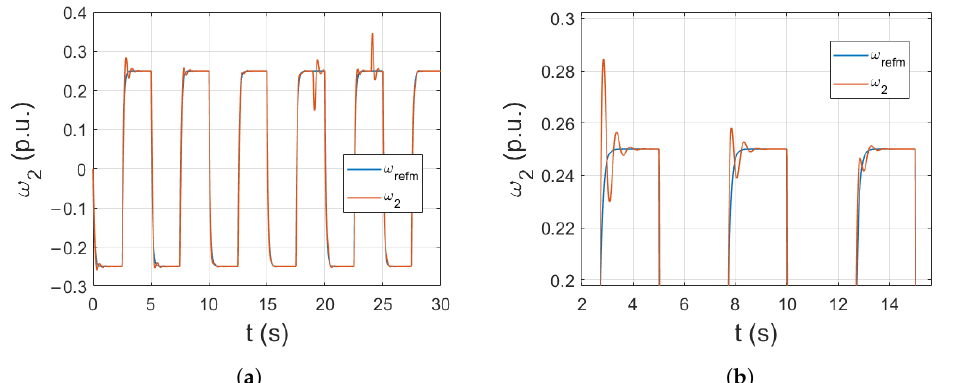
Figure 5. Operation of the drive with an increase in the inertia of the load machine ( T 2 = 2 T 2 n ) ( a ), with a zoom ( b